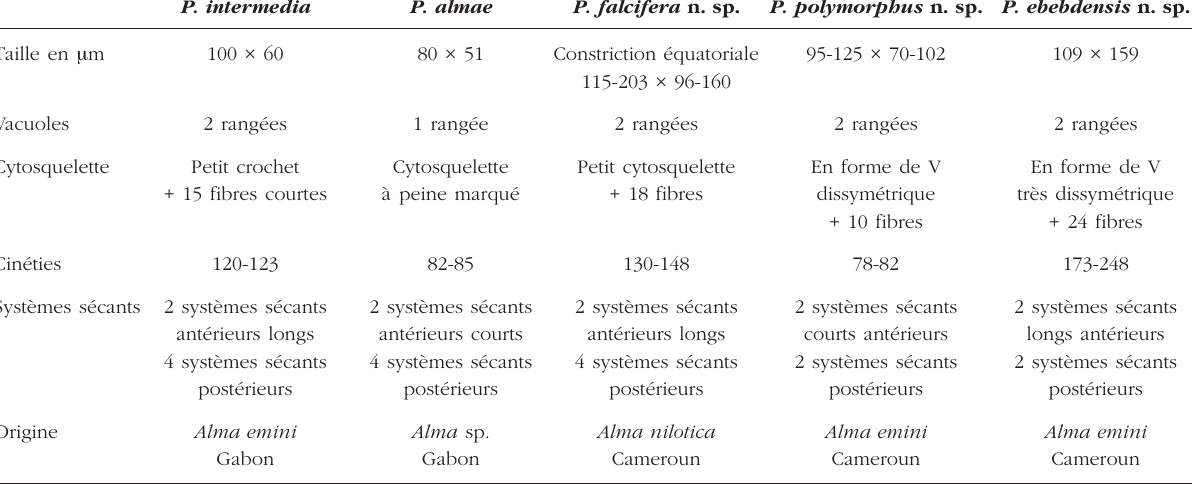
Tableau I. – Comparaison des ciliés du genre Paracoelophrya